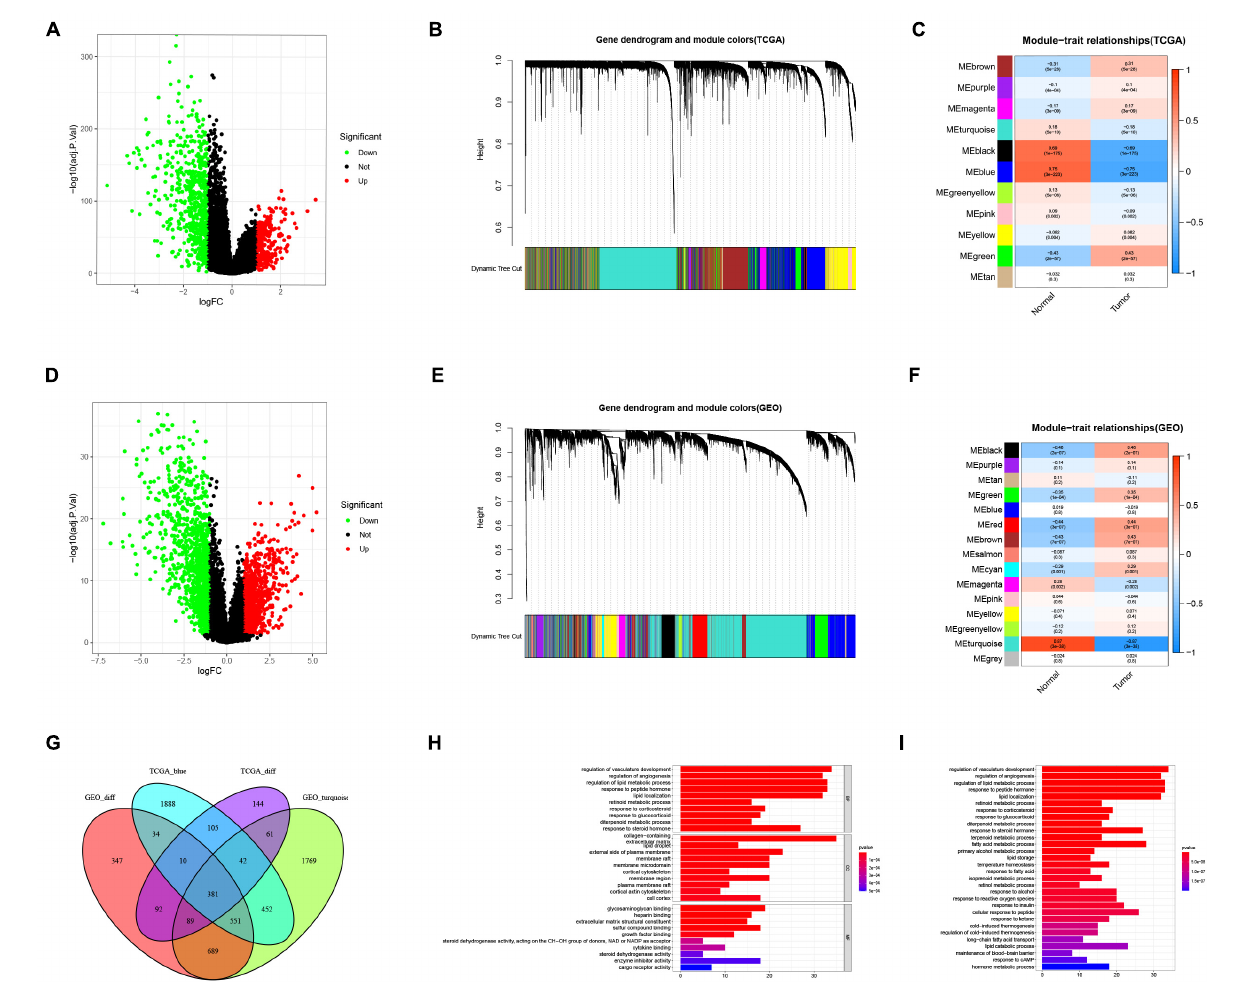
FIGURE 1 | Screening of breast cancer-related genes. (A) Identification of DEGs in TCGA data. (B) A dendrogram of the differentially expressed genes clustered based on different metrics in TCGA data. Each branch in the figure represents one gene, and every color below represents one co-expression module. (C) Heatmap of the correlation between the module eigengenes and BRCA in TCGA data. (D) Identification of DEGs in GEO data. (E) A dendrogram of the differentially expressed genes clustered based on different metrics in GEO data. (F) Heatmap of the correlation between the module eigengenes and BRCA in GEO data. (G) Venn diagram showed that there were 381 overlapping genes. (H) GO enrichment analysis. (I) KEGG enrichment